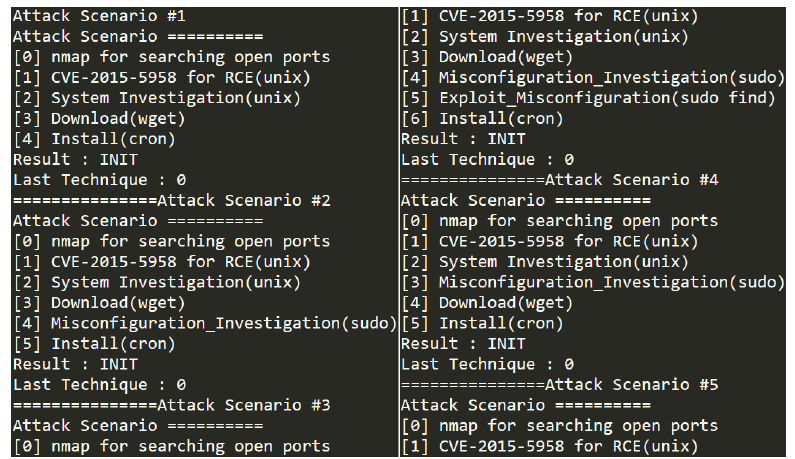
Figure 17. Examples of generated